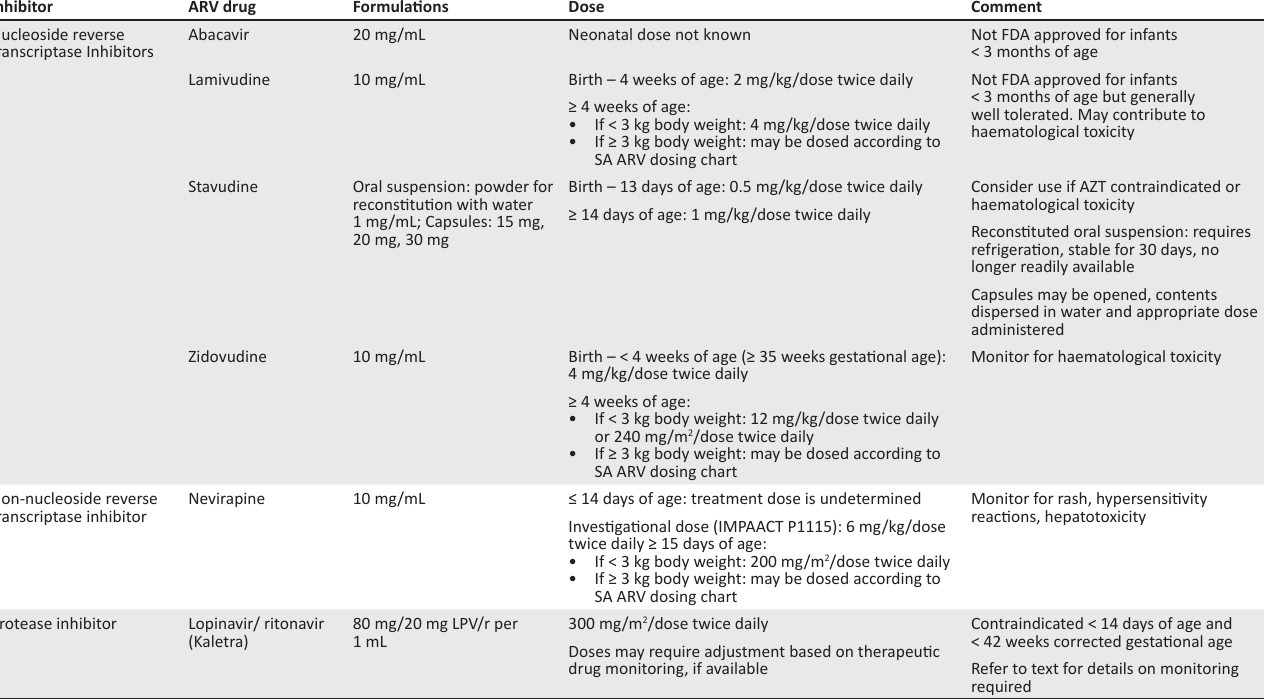
Source : Adapted from Ref. 11 Note: Body surface area (m 2 ) = (0.05 x weight [kg]) + 0.05. ARV, antiretroviral; LPV/r, Lopinavir/ritonavir; SA ARV, South African antiretroviral; IMPAACT, International Maternal Pediatric Adolescent AIDS Clinical Trials; FDA, Food and Drug Administration; AZT,